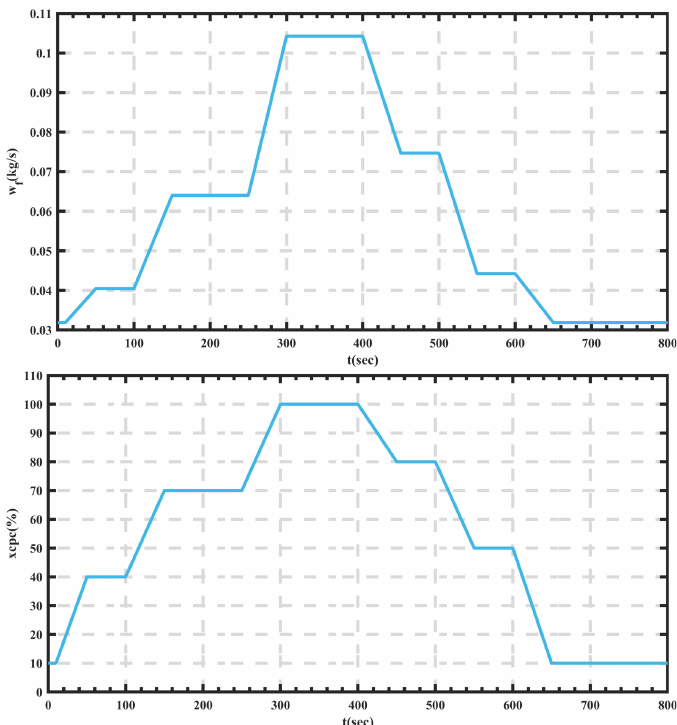
Figure 10. Ramp input signals of fuel w f and collective pitch xcpc .